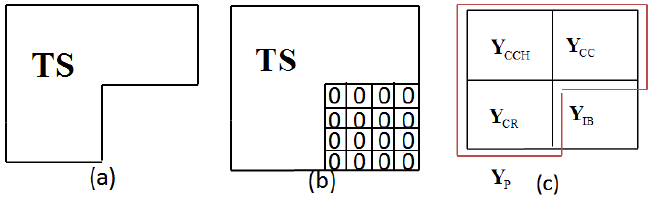
Figure 4. ( a ) Toggle syndrome TS ( b ) Toggle array T ( c ) Stego array Y.